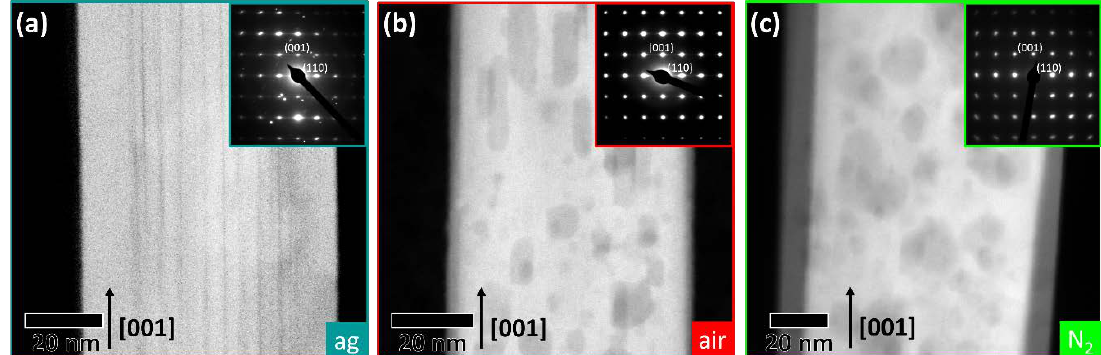
Figure 2. High-angle annular dark-field scanning transmission electron microscopy (STEM) image and a corresponding electron diffraction pattern (inset) for ( a ) an as-grown NW, ( b ) a NW annealed in air, and ( c ) a NW annealed in N 2 . All images show a representative area in the center of its respective NW and the diffraction patterns are taken from entire NWs.